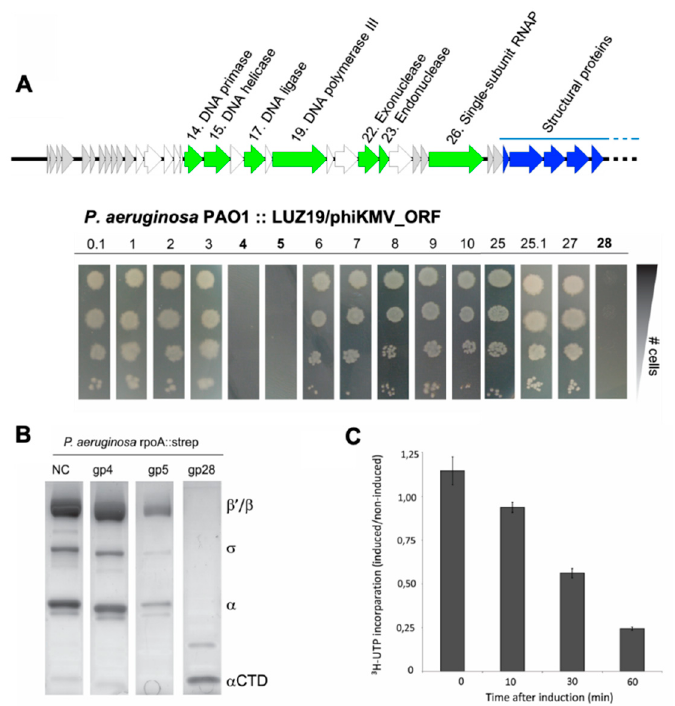
Figure 2. Phage gene 28 is responsible for α subunit cleavage. ( A ) Overview of the first part of the LUZ19 genome. Genes encoding proteins with predicted function are labeled in green, genes encoding structural proteins are blue. The first ten early genes and the two genes up- and downstream of the viral RNAP (highlighted in light grey) were selected and cloned into a single-copy plasmid, integrated in the P. aeruginosa PAO1 rpoA::strep genome. Dilution series of the cells were plated on LB with 1 mM isopropyl- β - d -thiogalactoside (IPTG) and checked for growth. ( B ) Pull-down analyses of the α RNAP subunit from cells grown in the presence of the indicated phage proteins (after 30 min induction with 1 mM IPTG). As negative control (NC), P. aeruginosa PAO1 rpoA::strep was used. Gp28 or Rac shows a consistent degradation of the RNAP α subunit. ( C ) Exponentially growing P. aeruginosa PAO1 cells containing Rac were pulse labeled with 3 H-uridine in the presence or absence of 1 mM IPTG. Each data point represents the average of three independent samples with standard deviation. For each timepoint, the scintillation counts for the induced sample were normalized to the non-induced sample at the same